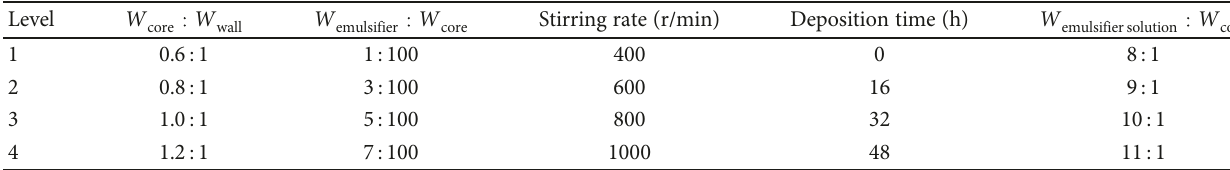
Table 1: In fl uencing factors and